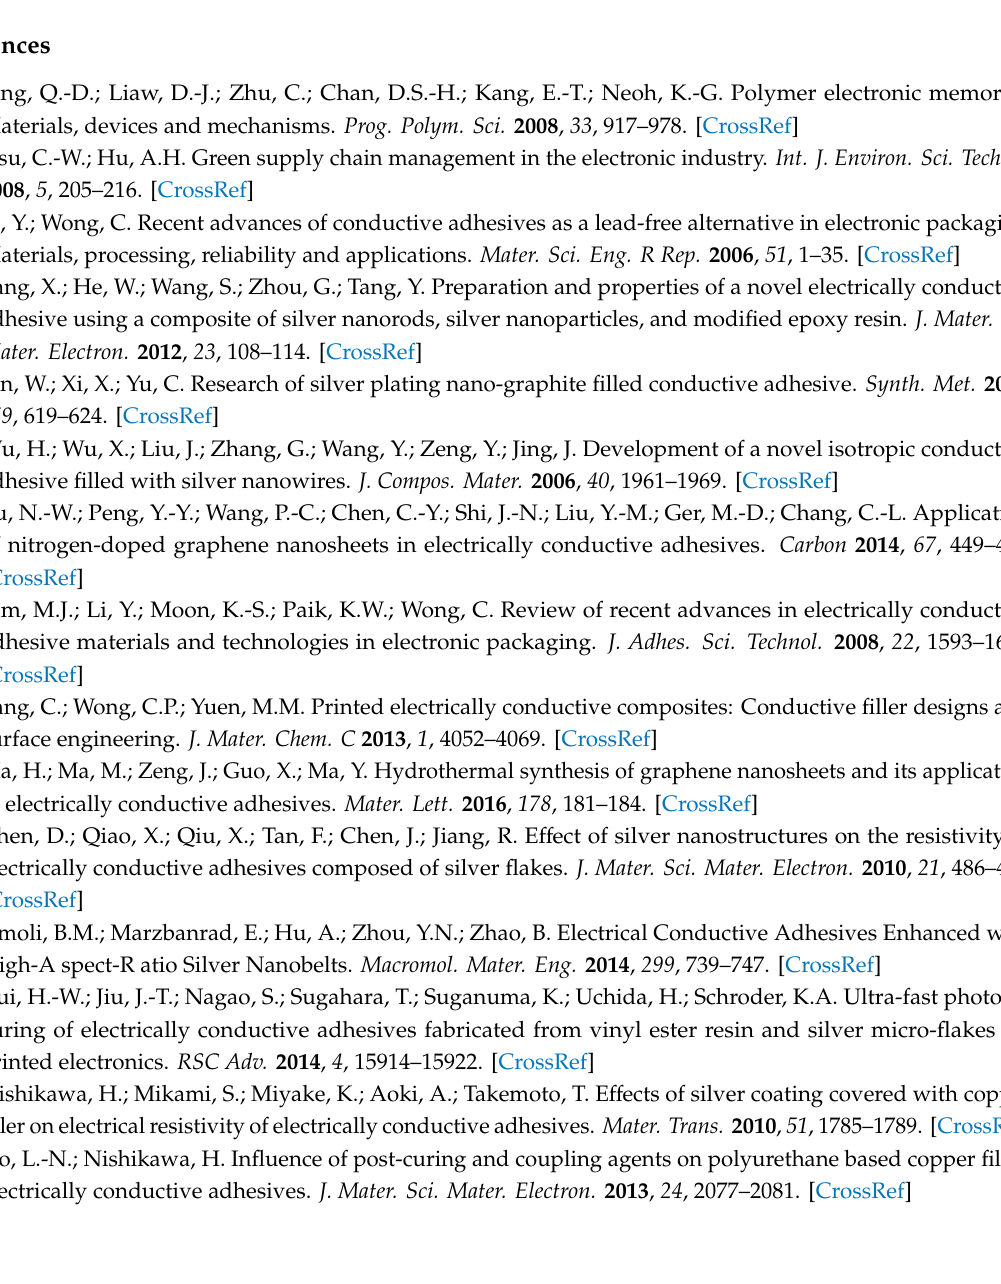
Figure S1: SEM images of (a) KS-6, (b) 8 µ m, (c) MoKS-6, (d) Mo8 µ m, (e) BN and (f) TiO 2 , Figure S2: Raman spectra of (a) KS-6, (b) 8 µ m, (c) MoKS-6 and (d) Mo8 µ m, Figure S3: Sheet resistance of MoKS-6, Mo8 µ m and MoKS-44, Figure S4: KS-44 and MoKS-44 composite with various content (a) BN and (b) TiO 2 , Table S1: KS-44 and MoKS-44 composite with various content BN and TiO 2